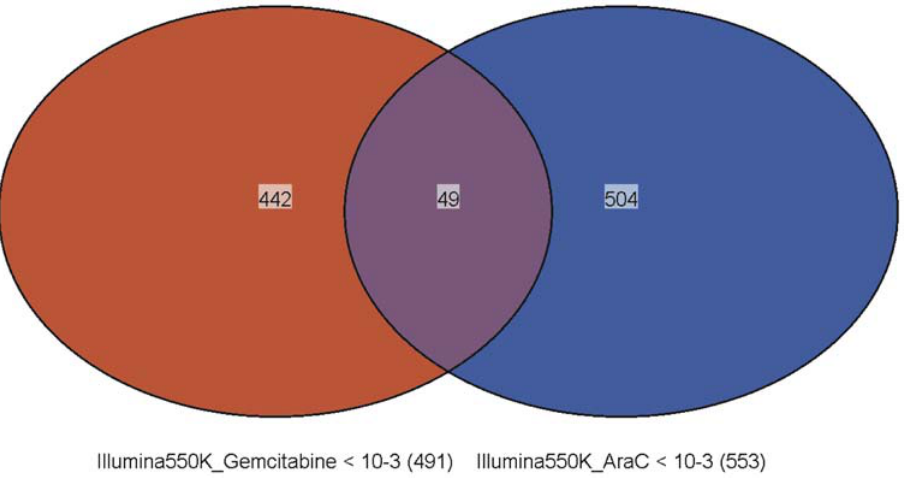
Figure 2. Top candidate SNPs that overlapped between gemcitabine and AraC. 49 SNPs were common (p , 0.001) among 442 unique SNPs associated with gemcitabine and 504 associated with AraC.